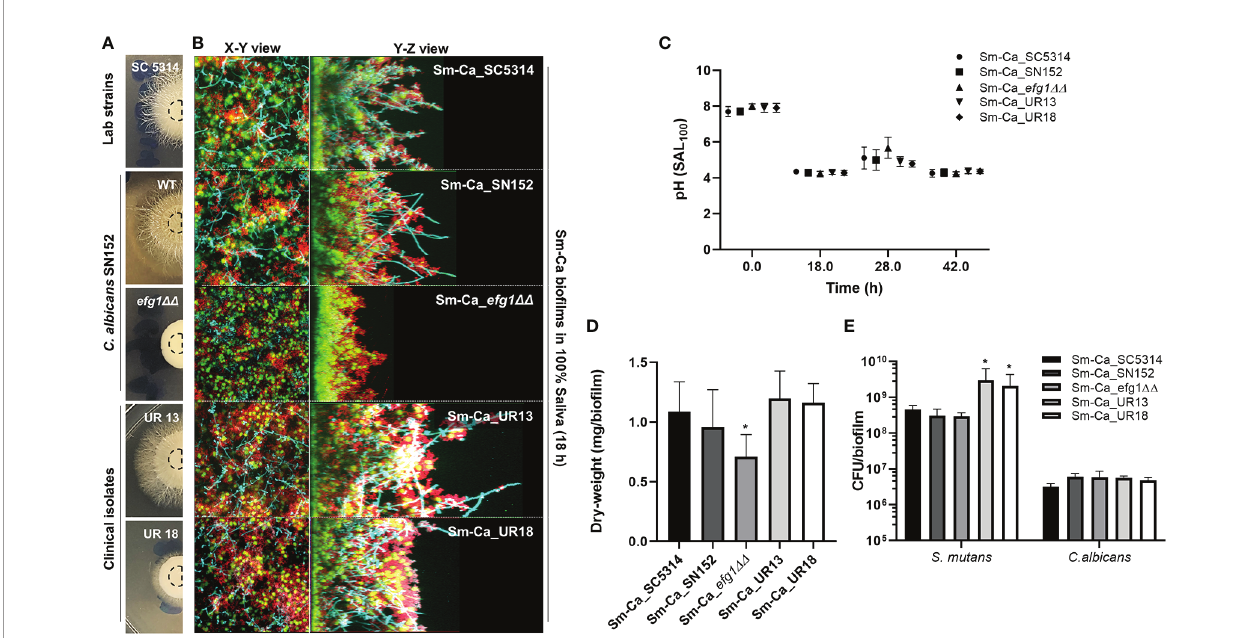
FIGURE 4 | Effect of hyphal transformation ability on the properties of Sm-Ca bio fi lms in saliva. (A) C . albicans colonies of SC5314, SN152, efg1 DD , UR13, and UR18 strains on Spider agar plate. Morphology of fungal colony was photographed after incubation for 4 days at 37°C. (B) Representative top (X – Y) and orthogonal (Y – Z) views of confocal images of each mixed-species bio fi lm under SAL 100 at 18 h. Bacterial cells are labeled with SYTO 9 (green), fungal cells with concanavalin A- tetramethylrhodamine (Cyan), and EPS a -glucan with Alexa Fluor 647 (red). (C) pH value at each time point (18, 28, and 42 h). Data were analyzed by descriptive analysis and one-way analysis of variance (ANOVA) using GraphPad Prism 8. (D) Total biomass (dry weight) of each Sm-Ca bio fi lm and (E) CFU of S. mutans and C . albicans at the endpoint (42 h). Asterisk indicates that the p -values are signi fi cantly different from wild type bio fi lm (Sm-Ca_SC5314) (ANOVA with Dunnett; * P <